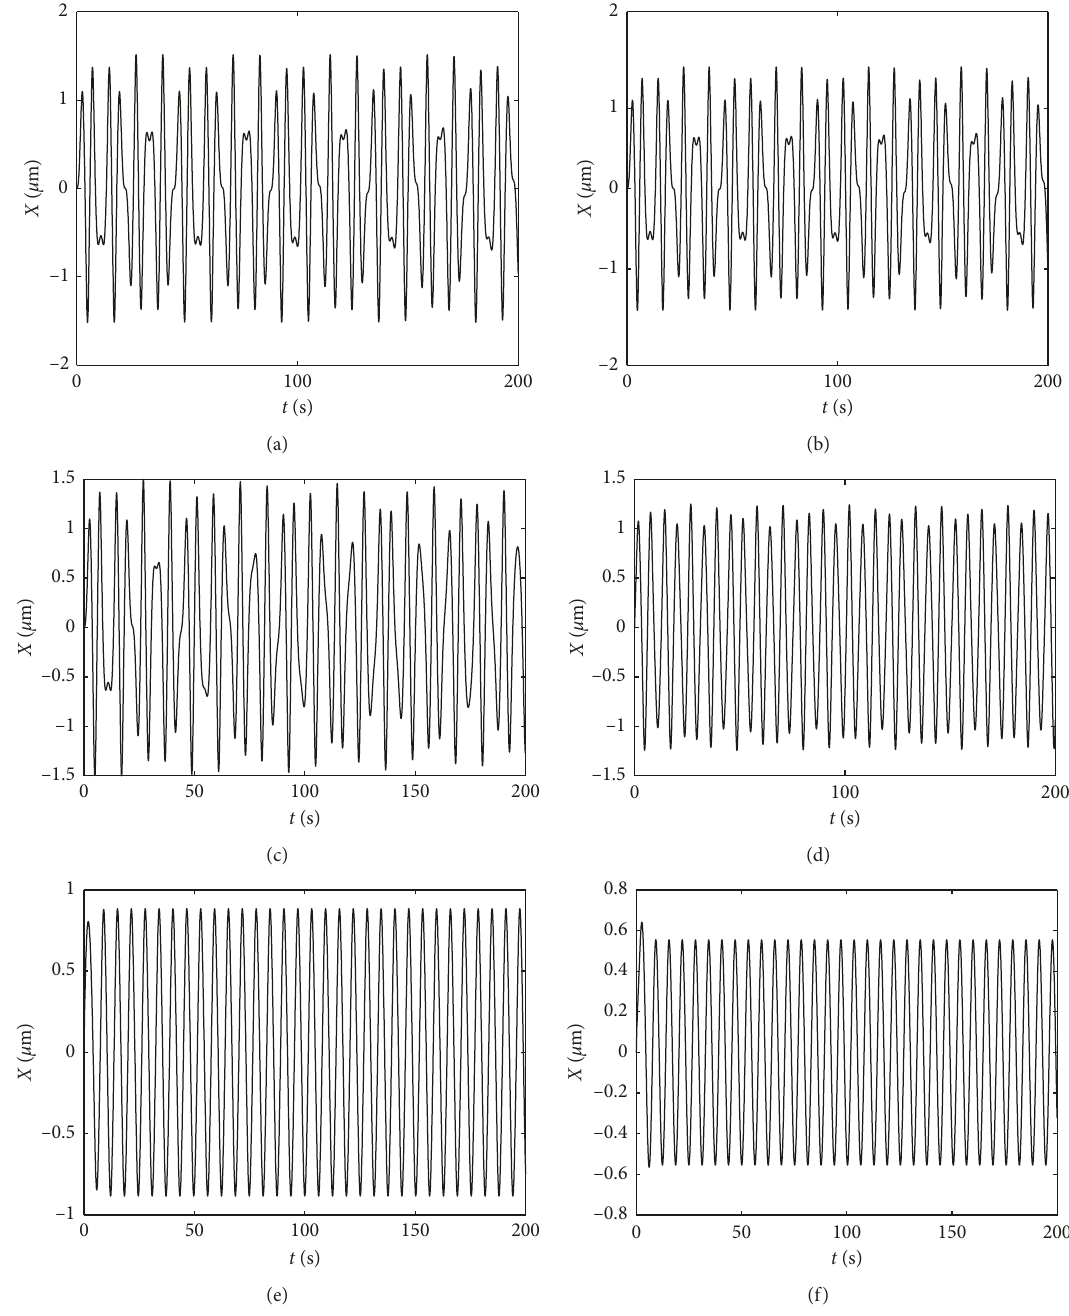
Figure 13: Wave diagram of displacement. (a) C � 5, (b) C � 7, (c) C � 150, (d) C � 200, (e) C � 220, and (f) C �